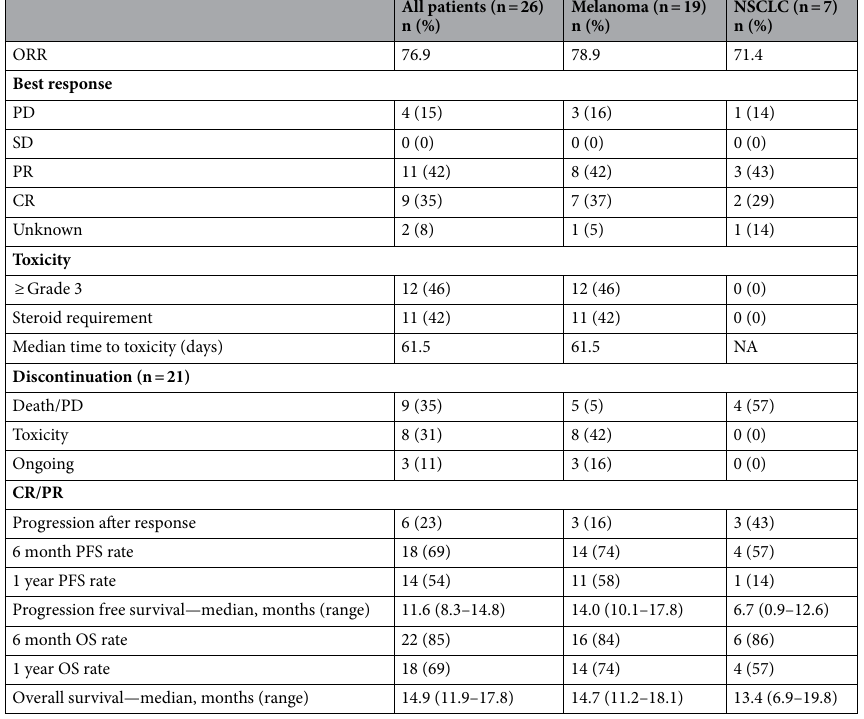
Table 2. Response assessment and survival